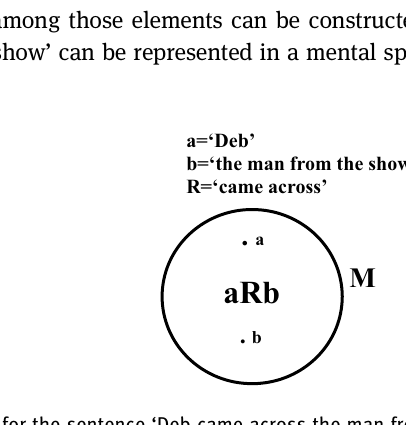
Figure 4: The mental space M for the sentence ‘ Deb came across the man from the show ’